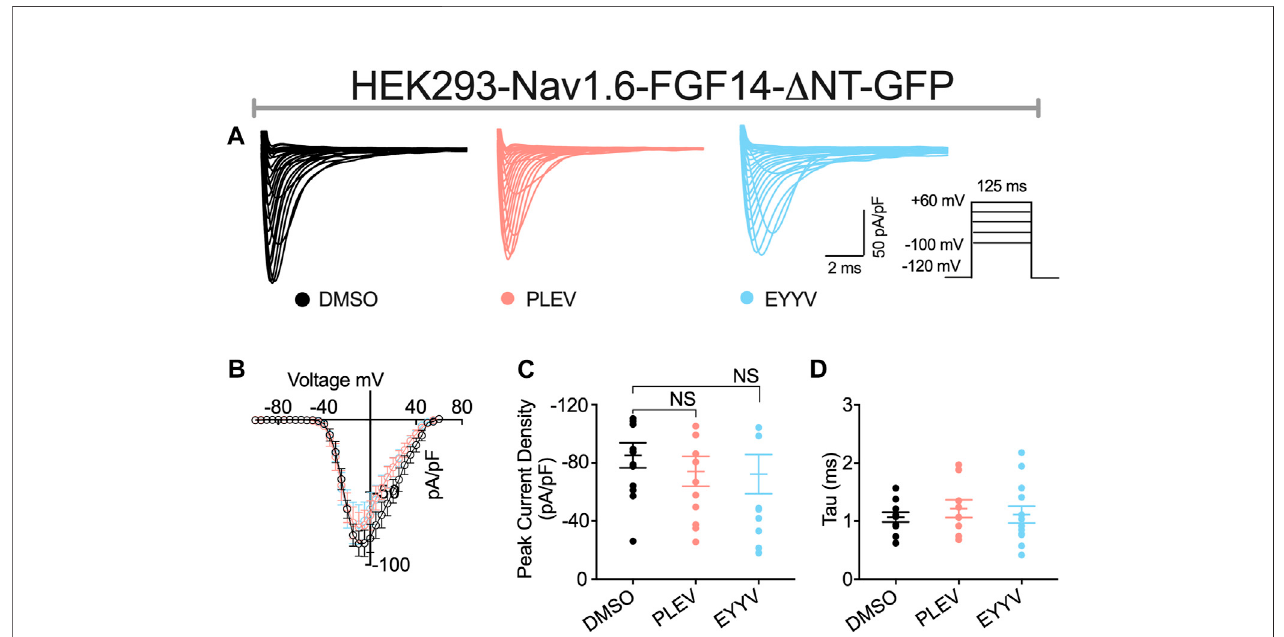
FIGURE5 | The N-terminal domain ofFGF14 isrequired for functionalactivity ofpeptides on peak transient INa density. (A) Representative traces oftransient Na+ currents elicited by HEK293-Nav1.6 cells co-expressing FGF14- Δ NT-GFP treated with 0.1% DMSO, 50 µM PLEV and 50 µM EYYV in response to voltage steps from − 100 mVto+60 mV,holdingpotentialof − 70 mV(inset). (B) Current-voltagerelationships forexperimentalgroupsdescribedin (A) . (C,D) Comparisonofpeaktransient INa density (C) and tau ( τ ) of fast inactivation (D) for the indicated experimental groups. Data are mean ± SEM. Signi fi cance was assessed using Student ’ s t -test comparing cells treated with 0.1% DMSO, 50 µM PLEV and 50 µM EYYV. NS (cid:2) non-signi fi cant. Table summary of results is shown in Table 2 .